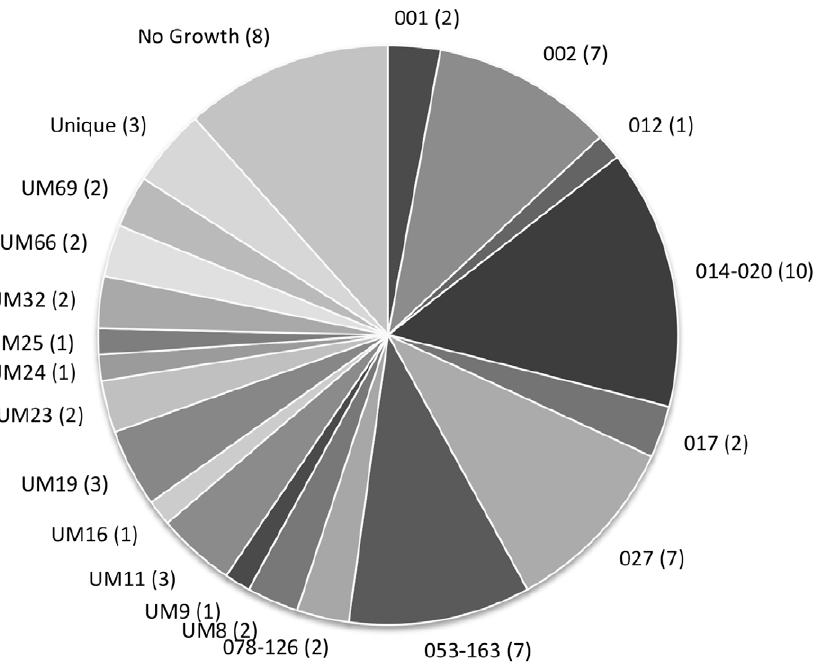
Figure 1. Illustration of Clostridiumdifficile isolates by ribotype. This chart shows a diverse population of Clostridium difficile isolates in our cohort. Twenty-two different ribotypes were identified. The prefix ‘‘UM’’ is used for ribotypes that were different from known reference isolates and were identified at the University of Michigan Health System (UMHS) more than once. The ‘‘Unique’’ grouping is for isolates that were identified only once at UMHS. Labels : Ribotype (number of patients).